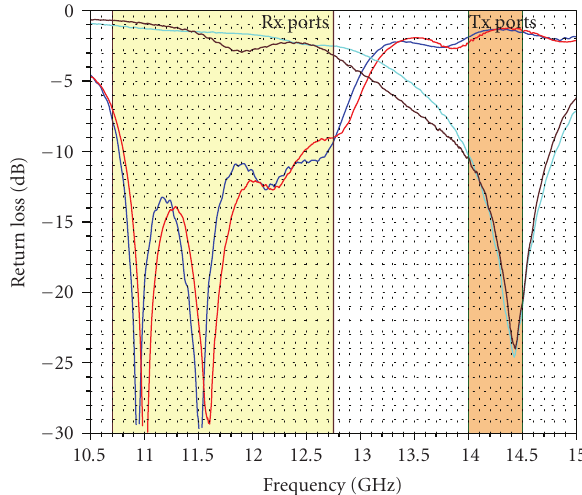
Figure 6: Measured radiating element return